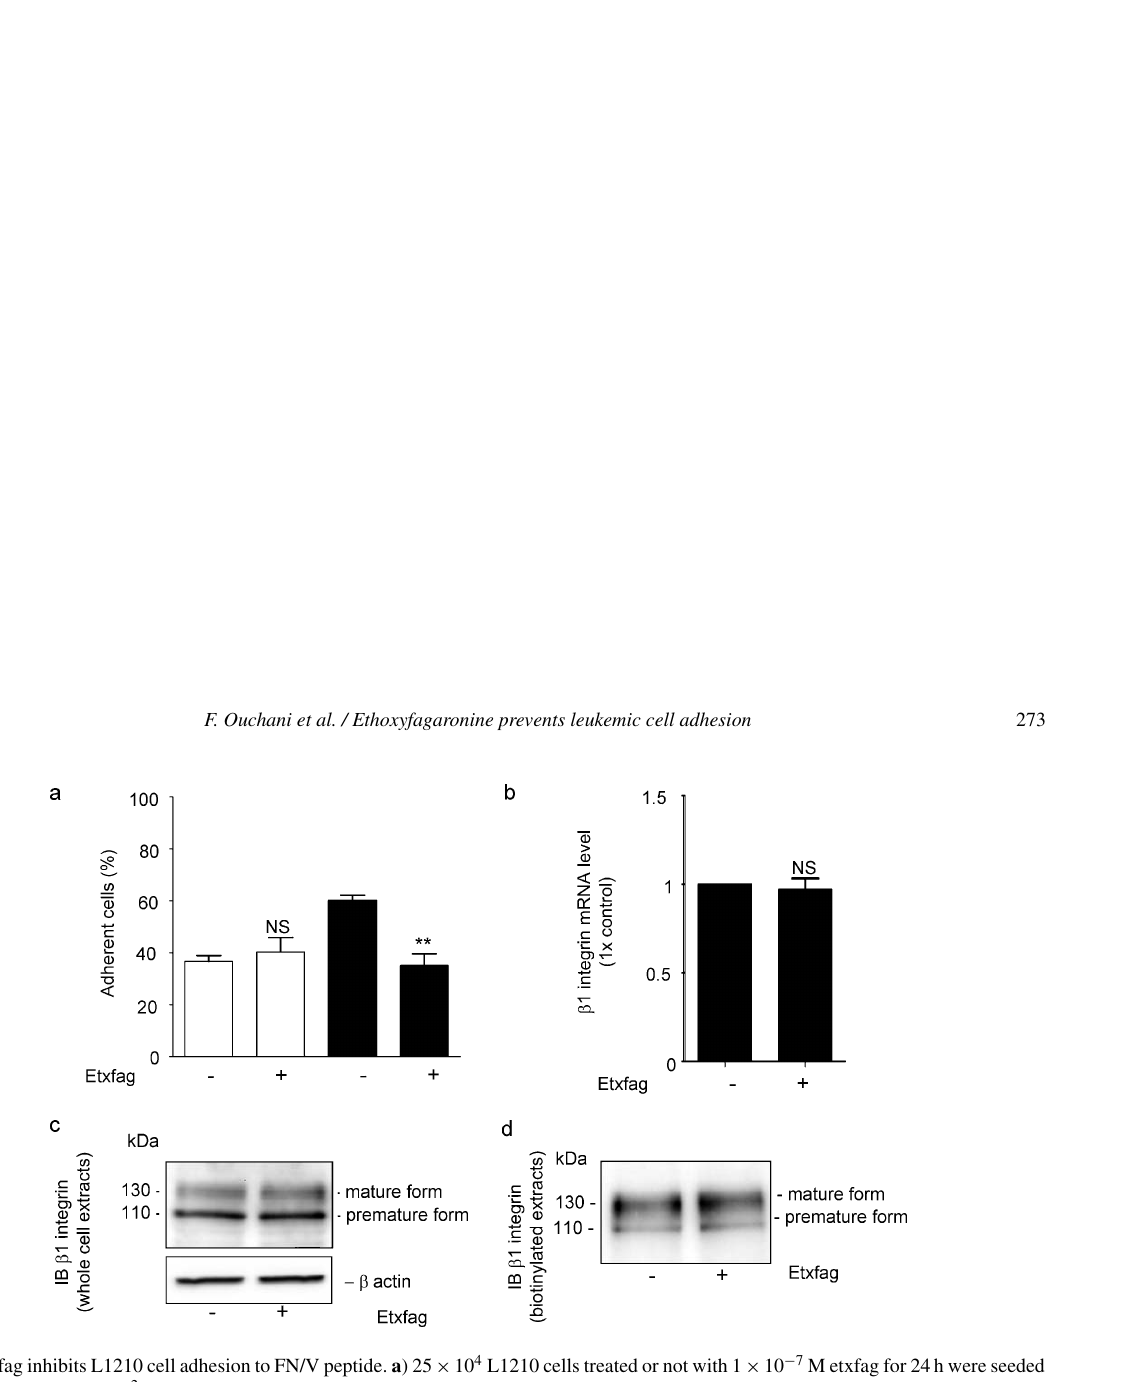
Fig. 2. Etxfag inhibits L1210 cell adhesion to FN/V peptide. a ) 25 × 10 4 L1210 cells treated or not with 1 × 10 − 7 M etxfag for 24h were seeded on 1% BSA ( (cid:1) ) or 5 (cid:3) g/cm 2 FN/V peptide ( (cid:2) ) for 2h. Cell adhesion was evaluated as described in Fig. 1a. ** P <0.01 versus to untreated cells. NS=non significative. b ) (cid:1) 1 integrin transcript levels were analysed by qRT-PCR as described in section 2. Error bars represent the SEM for the average fold change of at least three independent replicates. NS=non significative. c ) Whole cell extracts obtained from L1210 cells treated or not with 1 × 10 − 7 M etxfag for 24h were analysed by 10% SDS-PAGE followed by western blotting using anti- (cid:1) 1 integrin antibody. A representative blot of three independent experiments was shown. d ) L1210 cells were biotinylated and treated or not with 1 × 10 − 7 M etxfag for 24h. Biotinylated proteins were analysed by 10% SDS-PAGE followed by western blotting using monoclonal anti- (cid:1) 1 antibody. A representative blot of three independent experiments is